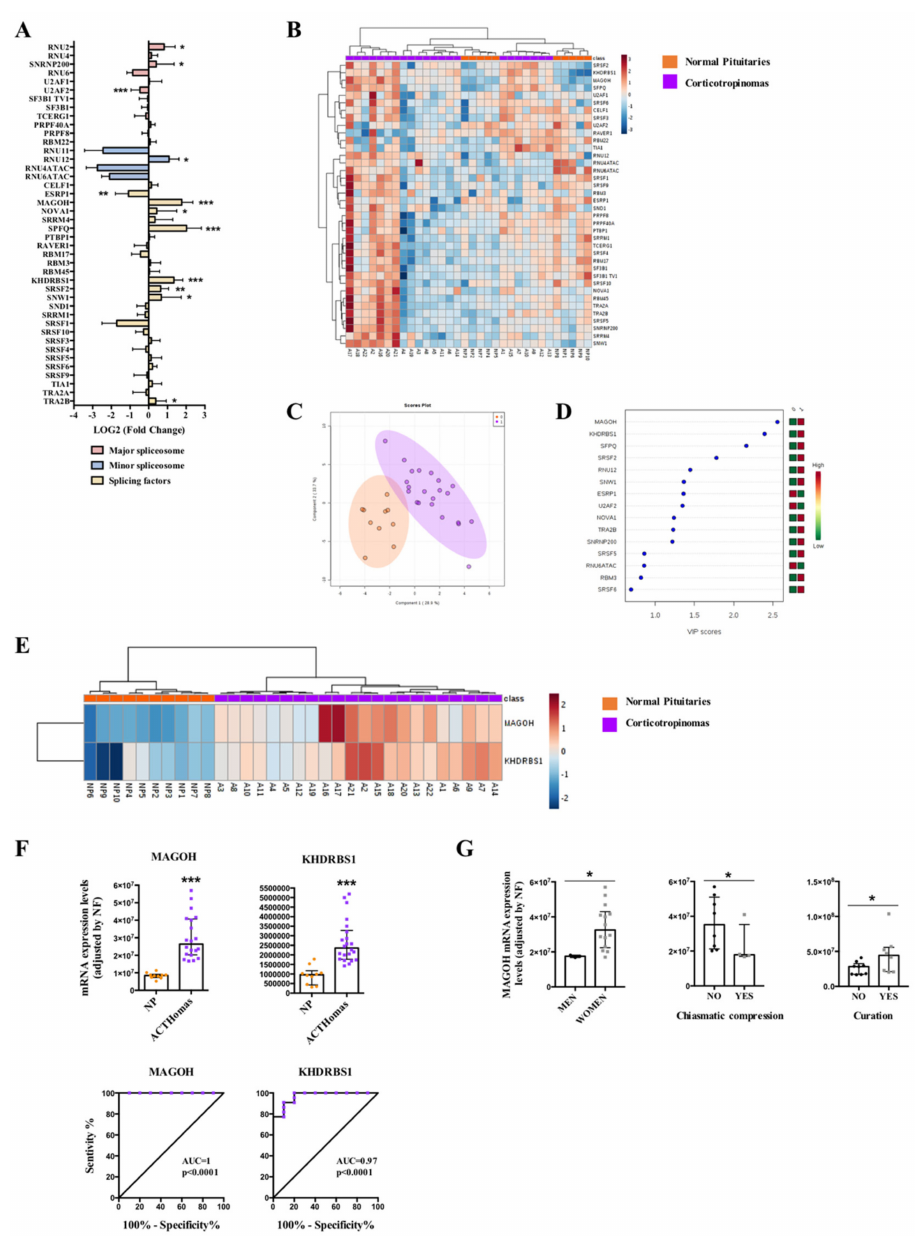
Figure 3. Corticotropinomas (ACTHomas). ( A ) Individual Fold-Change of each splicing-regulatory element expression levels in ACTHomas compared to normal pituitary glands (NPs). ( B ) Heatmap of the mRNA expression levels of all splicing-regulatory elements measured in the qPCR array in ACTHomas ( n = 22; green color) compared to NPs ( n = 10; red color). ( C ) Principal Components Analysis (PCA) of the mRNA expression levels of the splicing-regulatory elements analyzed in the same set of samples. ( D ) Variable Importance in Projection (VIP) Scores top-feature of Partial Least Squares Discriminant Analysis (PLS-DA). ( E ) Heatmap of the splicing-regulatory elements with higher VIP score in the same set of samples. ( F ) mRNA expression levels of splicing-regulatory elements with higher VIP score in ACTHomas compared to NPs and Receiver Operation Characteristic (ROC) curves analyses showing the accuracy of the selected splicing-regulatory elements to discriminate between ACTHomas and NPs. ( G ) Correlations between MAGOH and clinical parameters. Data represent median ± interquartile range of absolute expression levels (copy number) of each transcript adjusted by a normalization factor. Asterisks (* p < 0.05, ** p < 0.01, *** p < 0.001) indicate statistically significant di ff erences between